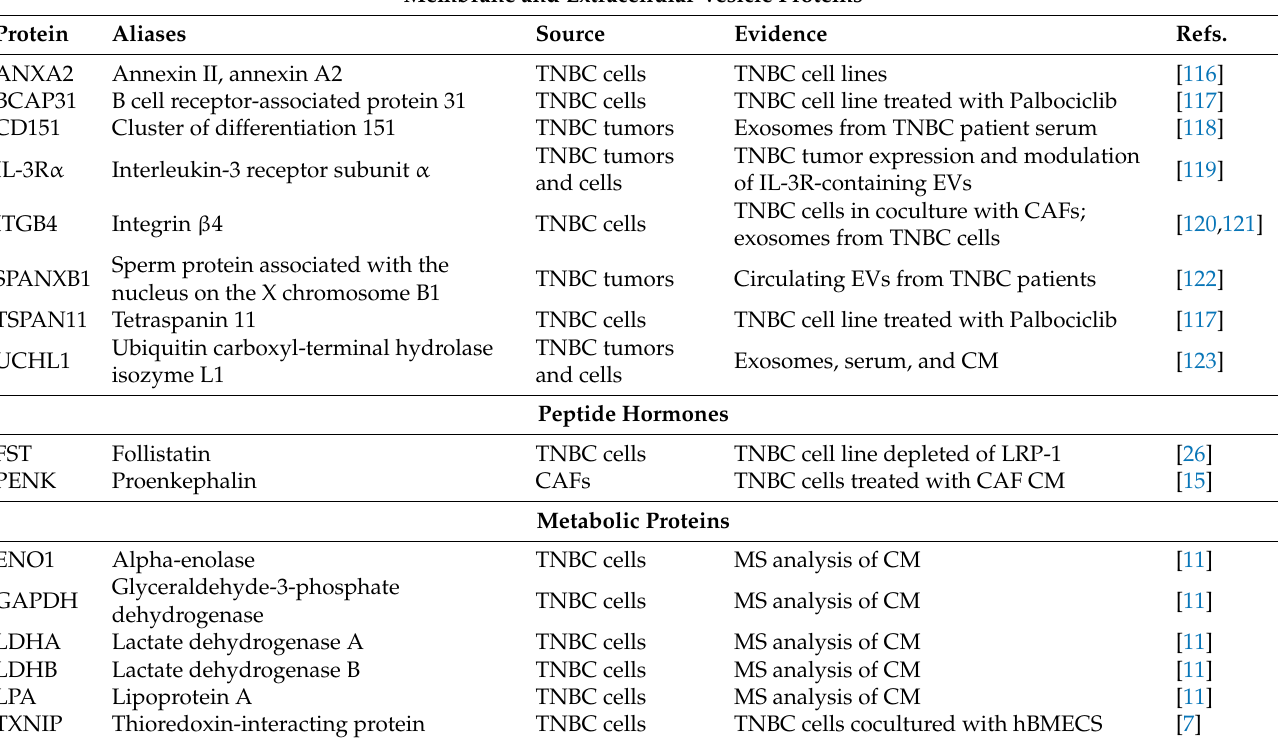
Table 4. Other Proteins of the TNBC